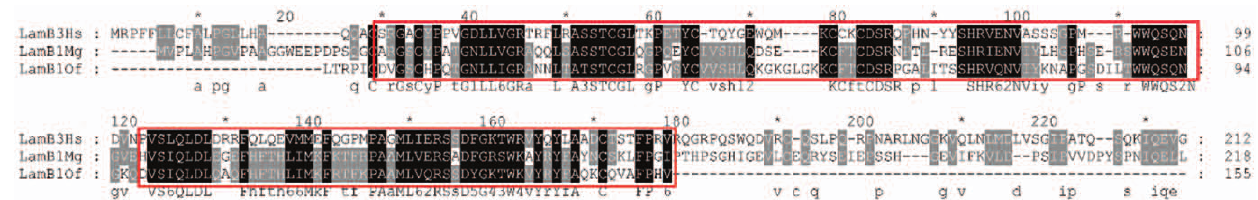
Figure 6. Comparison of laminin subunit b through pairwise alignment of b 3 laminin of Homosapiens (LamB3Hs, gi|119613854), b 1- like of the turkey Meleagrisgallopavo (LamB1Mg, gi|326911240) and b 1-like of Oncopeltusfasciatus (LamB1Of). The alignment of b 3 laminin of H. sapiens and b 1-like of M. gallopavo with the partial sequence of b 1-like identified in the transcriptome of O. fasciatus embryo [28] shows a highly conserved region at the domain VI among these molecules. Black shaded residues are identical or similar amino acids present in all three sequences. Grey shaded residues are identical or similar amino acids present in two of the three sequences. The consensus sequence is represented under alignment lines. In the red rectangles are highlighted the regions with higher similarity between all three sequences. The alignments were performed using GENEDOC software [90].